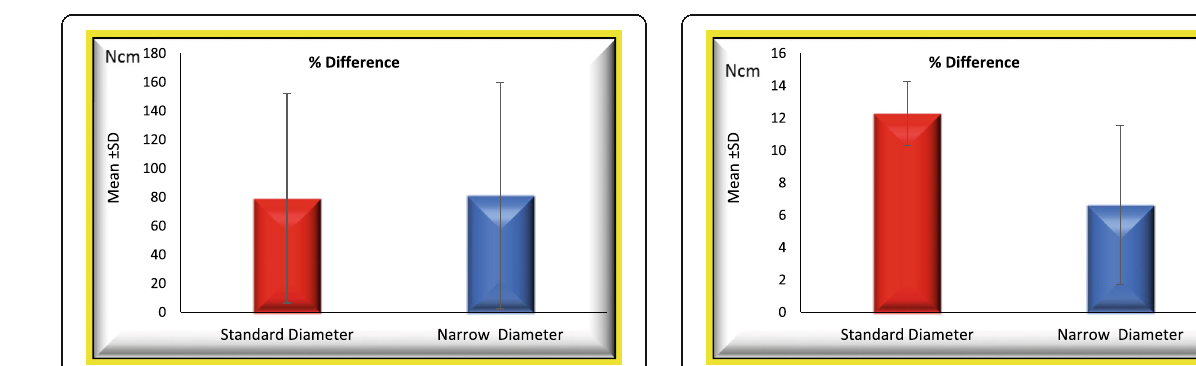
Fig. 4 Mean of percentage difference between initial and post load RTL